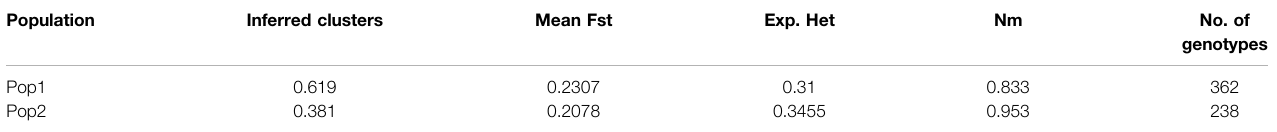
TABLE 1 | The STRUCTURE results of 600 bread wheat landraces for the fi xation index (Fst), average distances (expected heterozygosity/He), gene fl ow (Nm), and the number of genotypes assigned to each subpopulation.